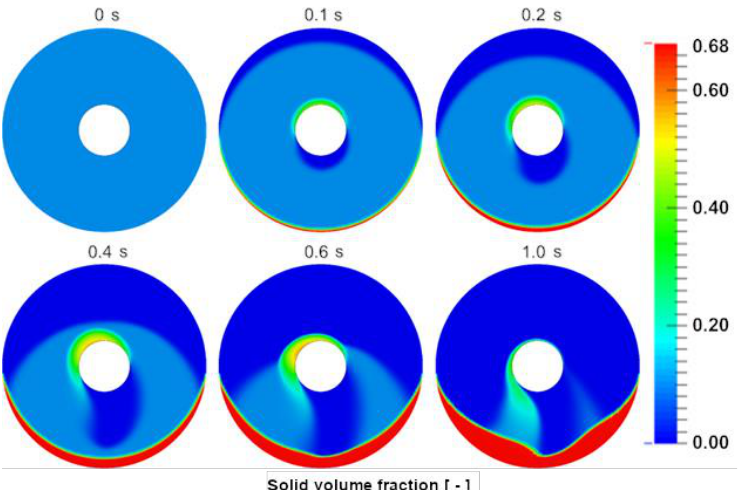
Figure 8. Volume fraction of the solid component at different time steps predicted by the proposed particle flux model.